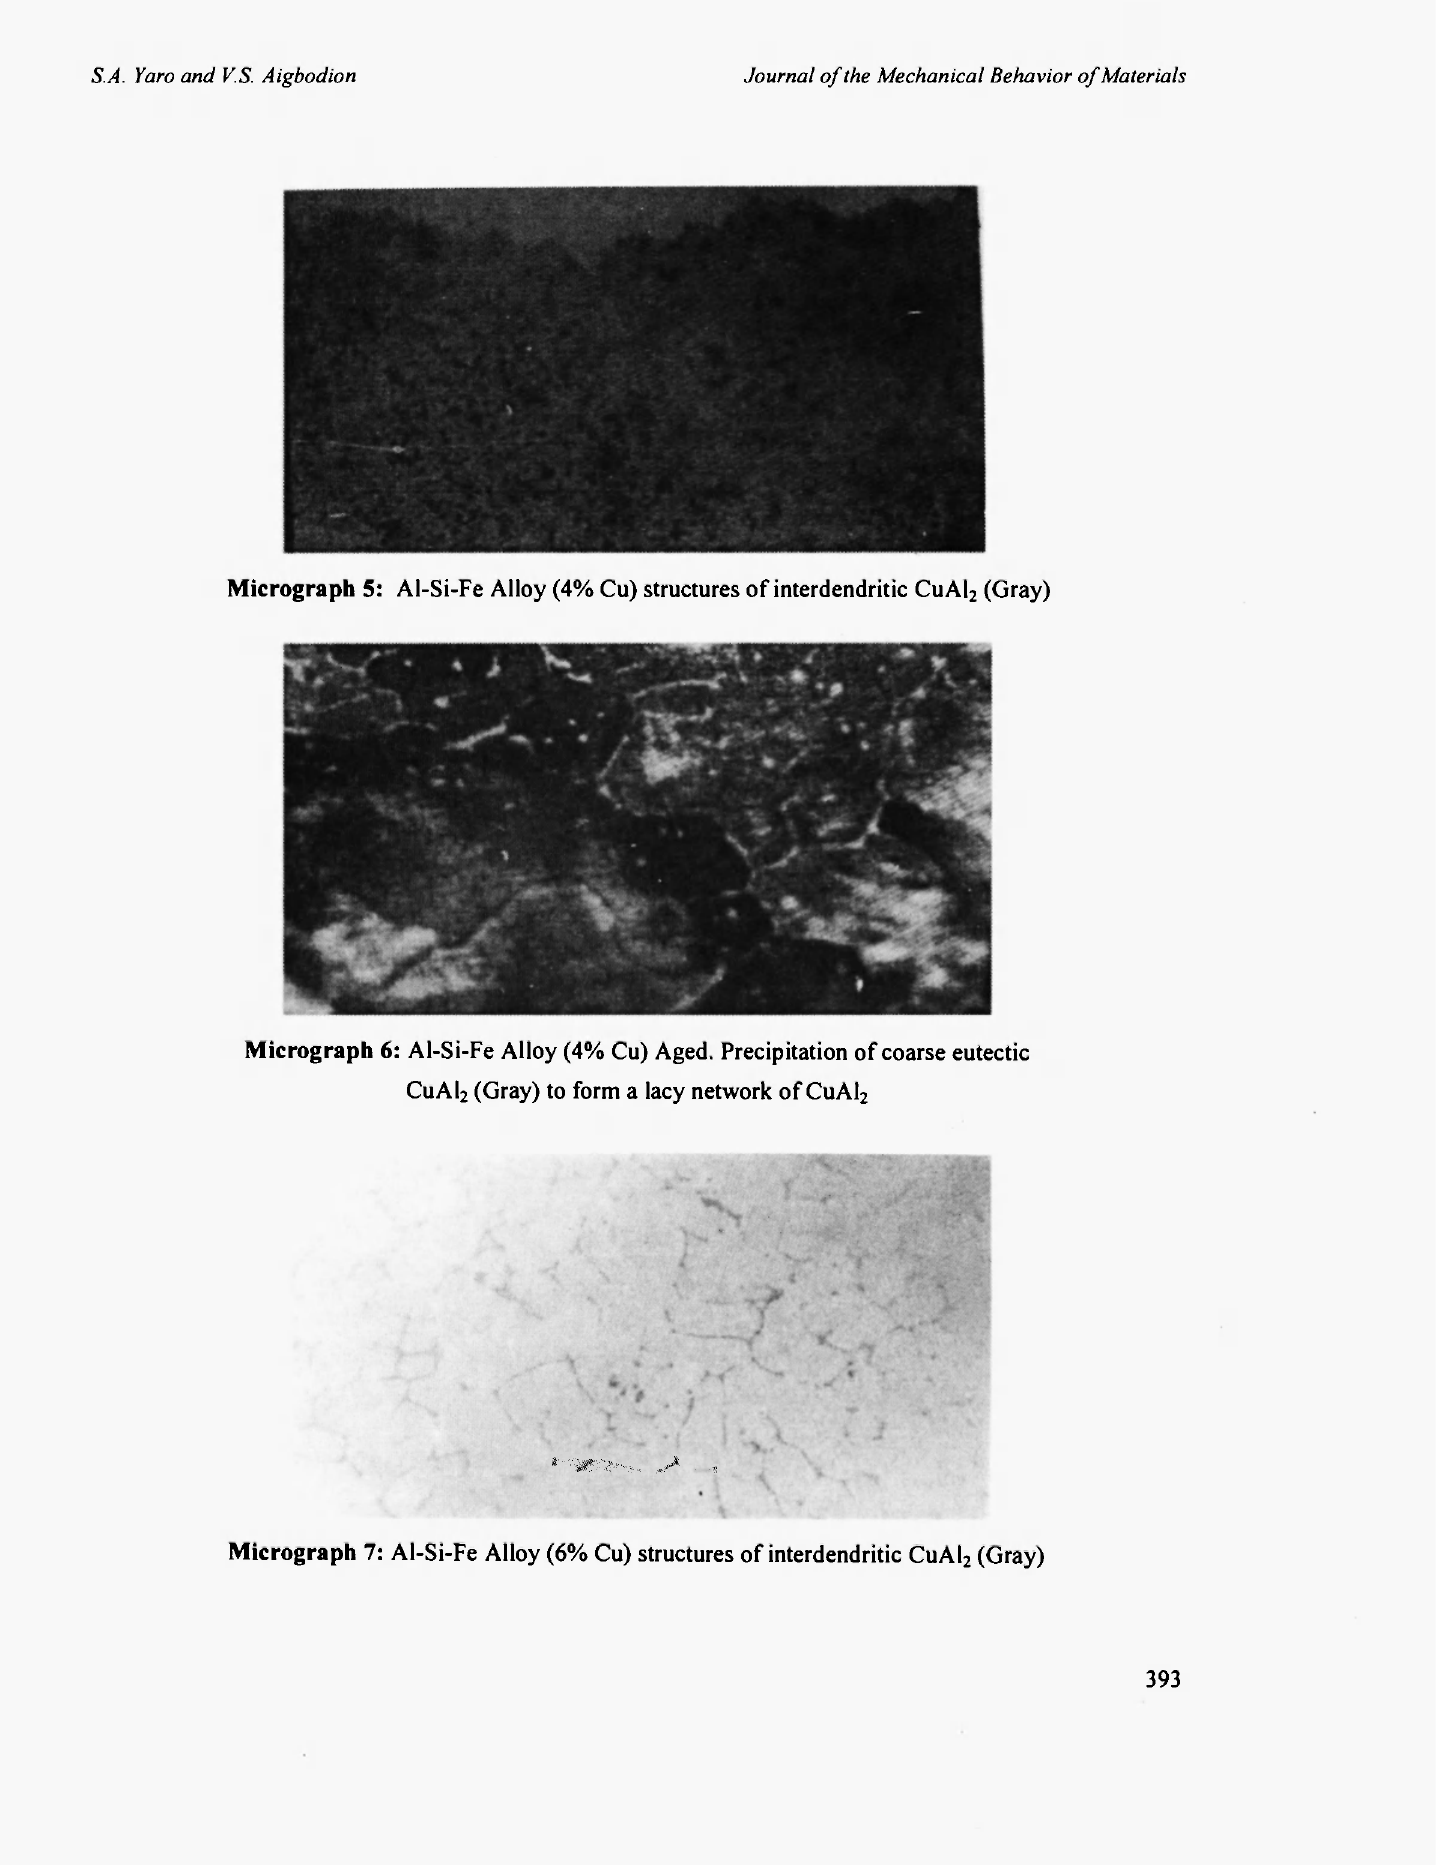
Micrograph 7: Al-Si-Fe Alloy (6% Cu) structures of interdendritic C U A1 2 (Gray)